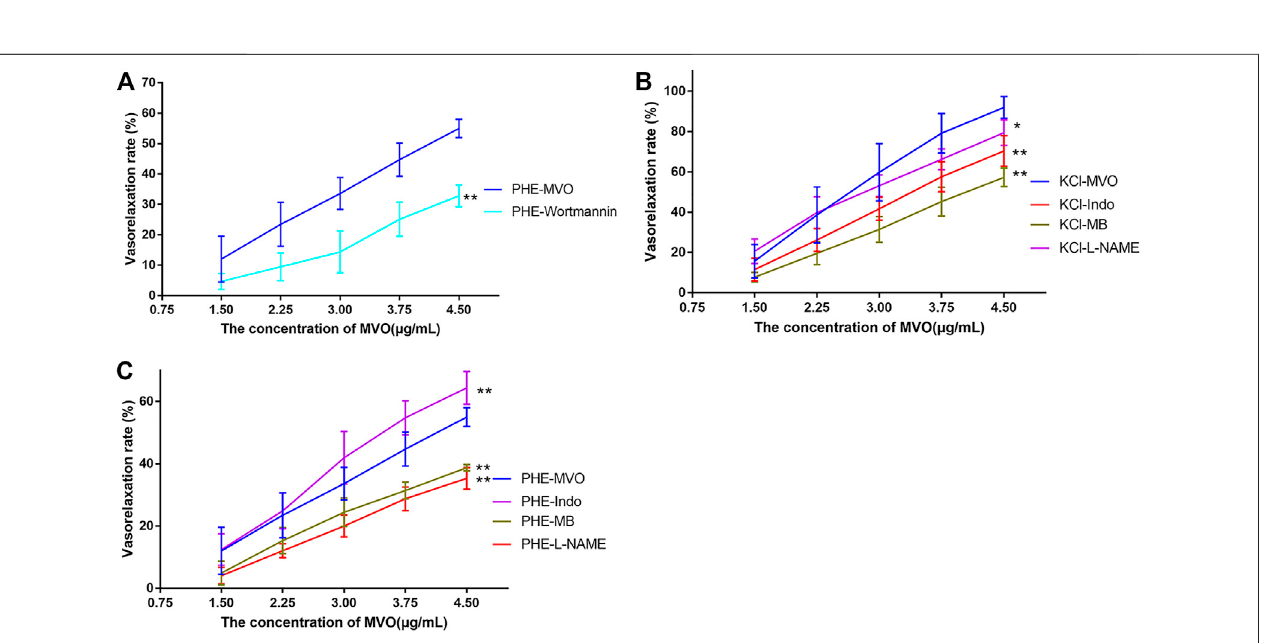
Frontiers in Pharmacology |